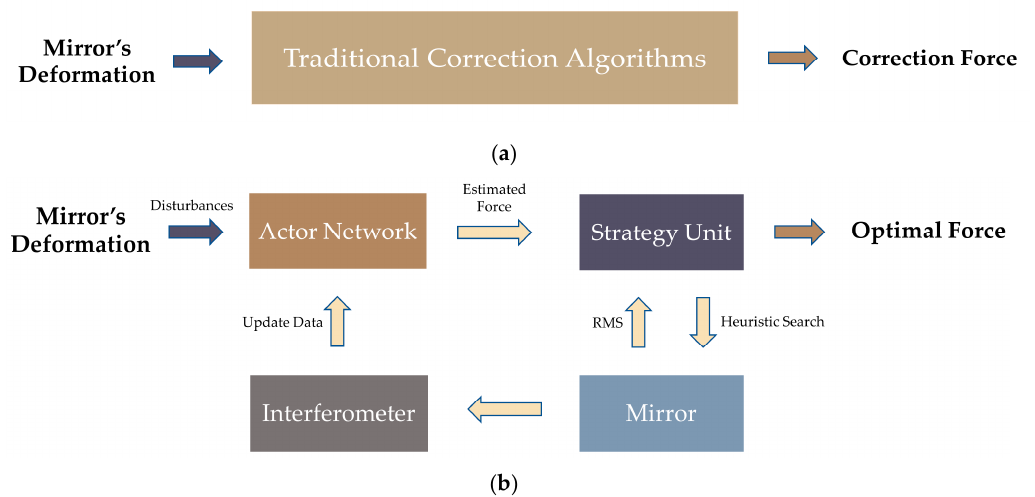
Figure 2. The difference of structure between the traditional correction algorithms and the deep learning correction algorithm (DLCA). ( a ) The structure of the traditional correction algorithm; ( b ) The structure of the DLCA.